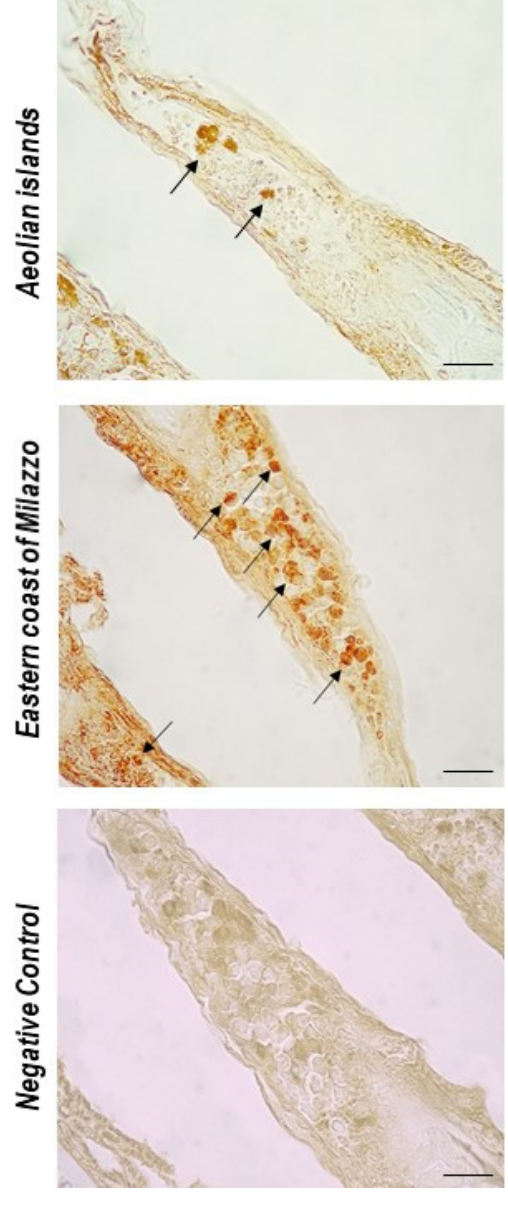
Figure 3. Boops Boops gill sections. Immunoperoxidase with anti-S100, 100×, scale bar 100 μ m. An increase of RCs (arrows) immunopositive to S100 is evident in the gills of fish from the eastern coast of Milazzo.